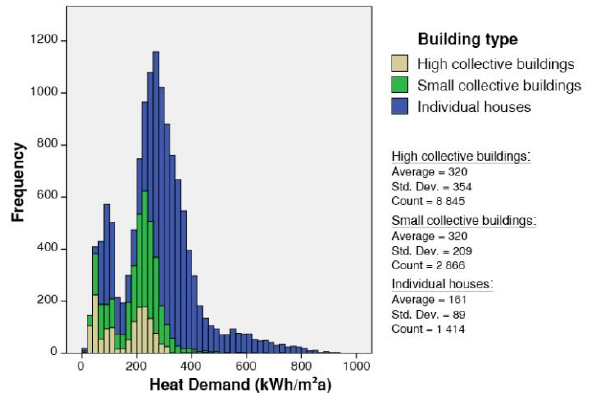
Figure 4: Distribution of the heat energy demand per building type considering the scenario A “construction state”.